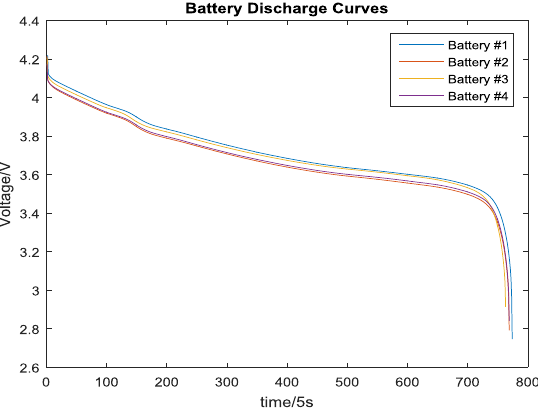
Figure 1. Our designed measurement system.